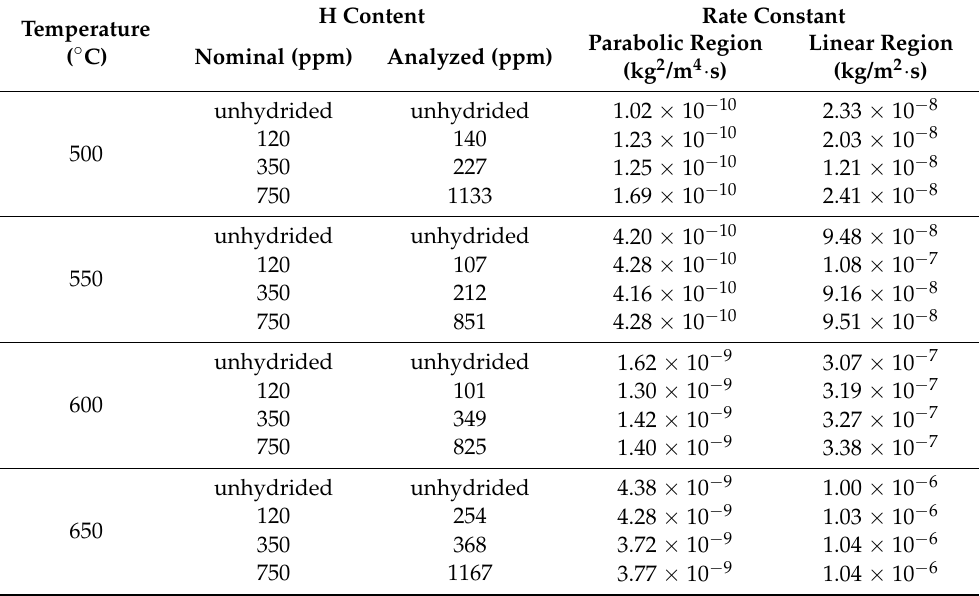
Table 2. Oxidation rate constants for the Zircaloy-4 cladding in the parabolic and linear rate regions.